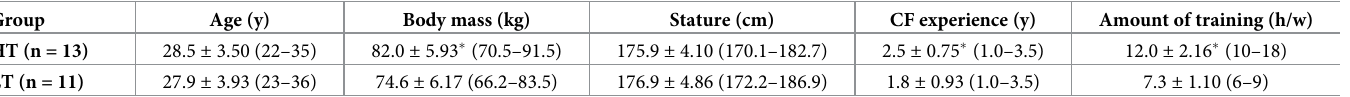
Table 1. Characteristics of participants in the Higher Training (HT) and Lower Training (LT) groups. Data are means ± SD (Minimum-Maximum). One-way ANOVA.